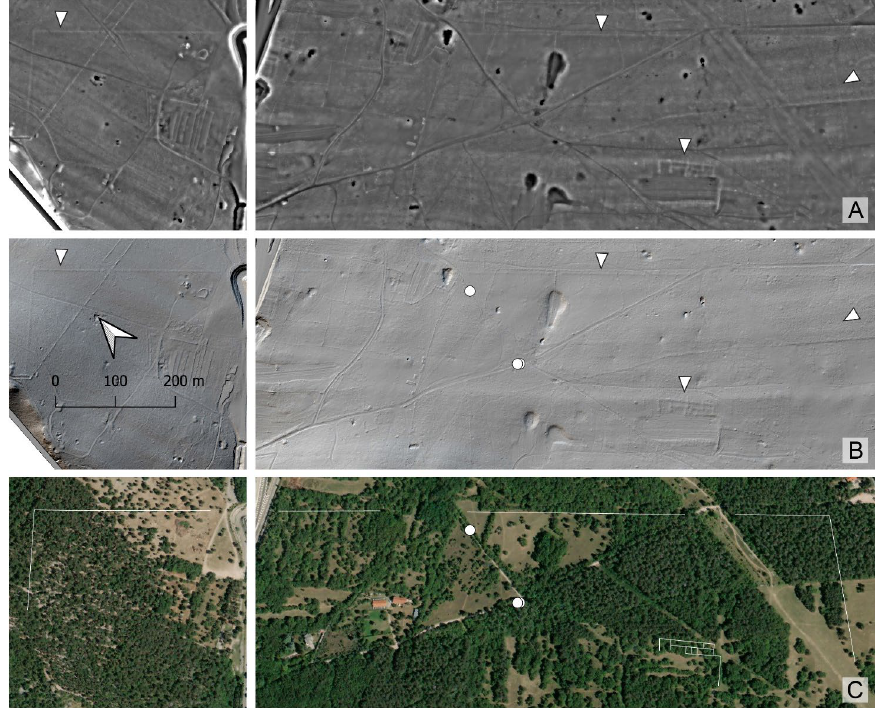
Figure 16. Zoomed view of area I of Figure 2 with the position of a rural building surrounded by the remains of a boundary wall indicated by white arrows in pictures ( A ) (local relief model of an ALS-derived DTM) and ( B ) (hill-shaded image of an ALS-derived DTM) and by white lines in picture ( C ) (satellite image). White circles: caliga hobnails.